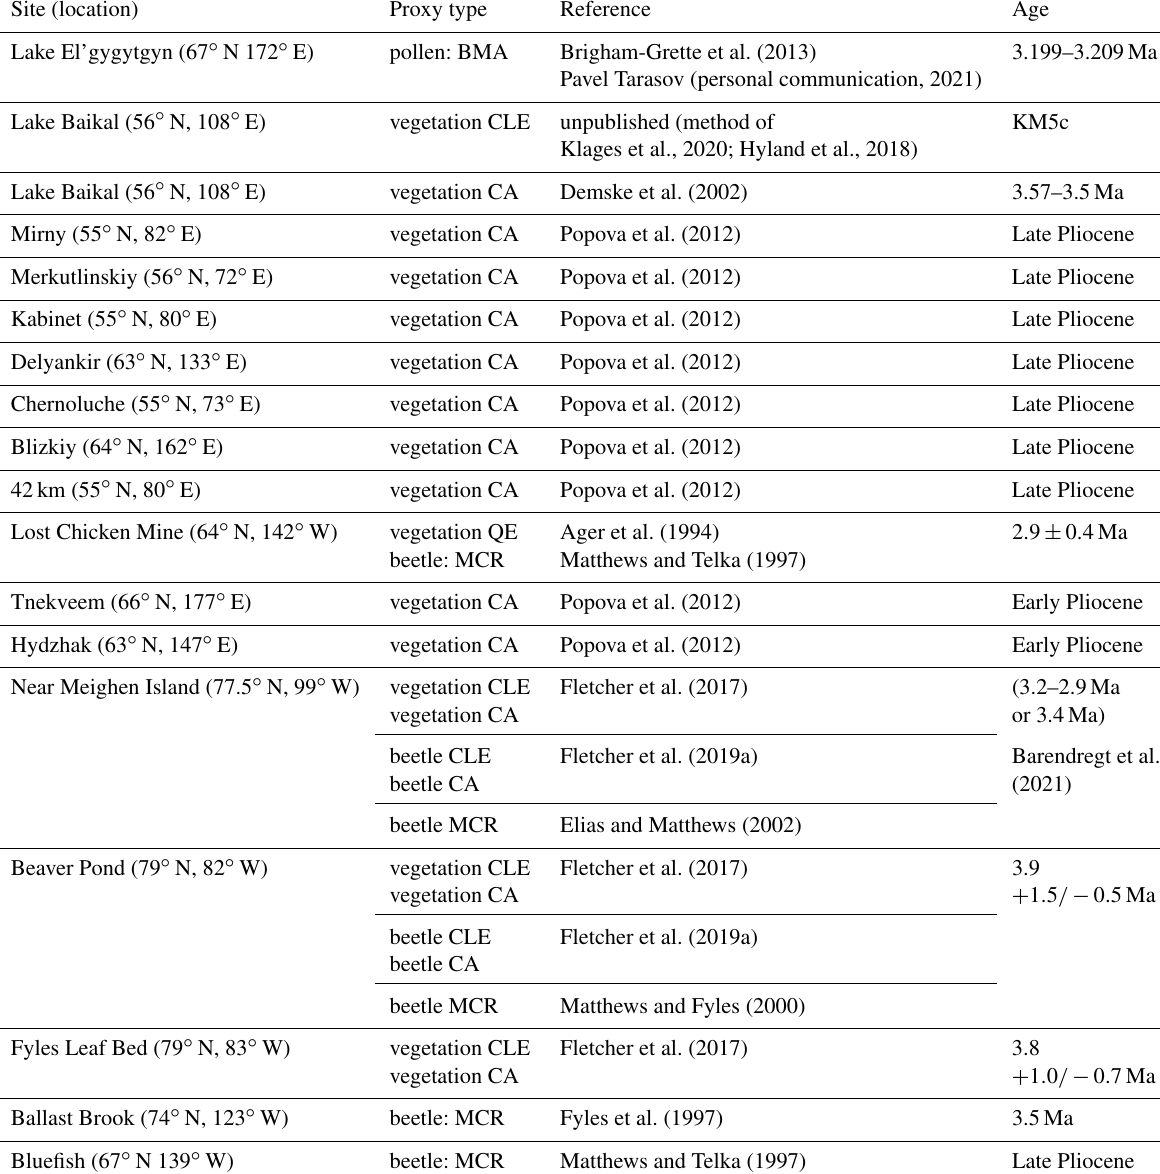
Table 3. Metadata for the DMC in Figs. 3 and 4. BMA – best modern analogue (Overpeck et al., 1985), CA – coexistence approach based on Mosbrugger and Utescher (1997), CLE – coexistence likelihood estimation, QE – qualitative estimates using modern analogues, MCR – mutual climatic